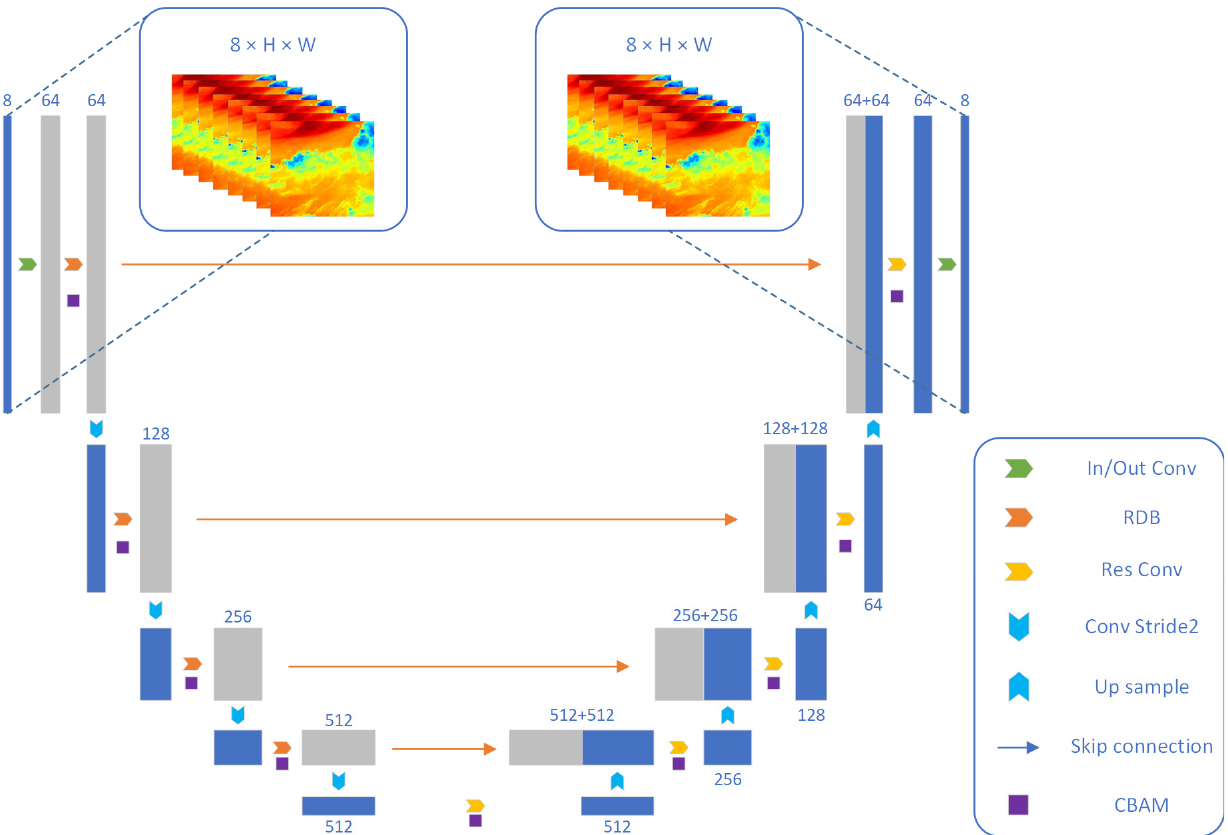
Figure 3. The structure of the CSIP-Net. The CSIP-Net is a fully convolutional network with an encoding-decoding structure, using four downsampling and four upsampling. A CBAM was added to the RDB unit and the Res Conv unit. The numbers in the figure represent the number of channels in each layer of the model. The input of the network is the satellite infrared observation image sequence data and the output result is the predicted satellite infrared image sequence for the future 2 h.